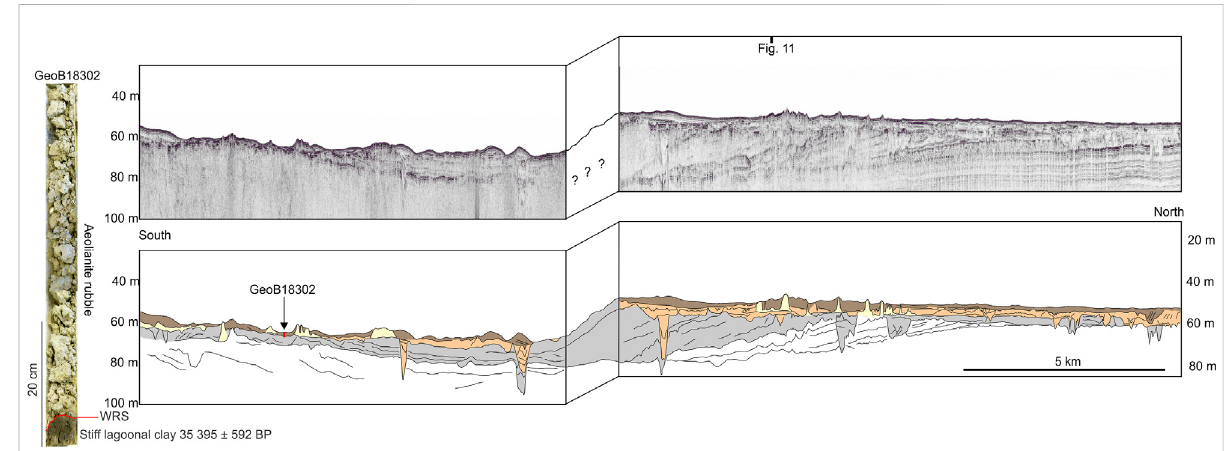
FIGURE 8 Interpreted(top)andraw(bottom)seismicre fl ectiondataoffshoreDurban.Thedatahighlightaseriesofincisionsintopaleo-landsurfaces.The